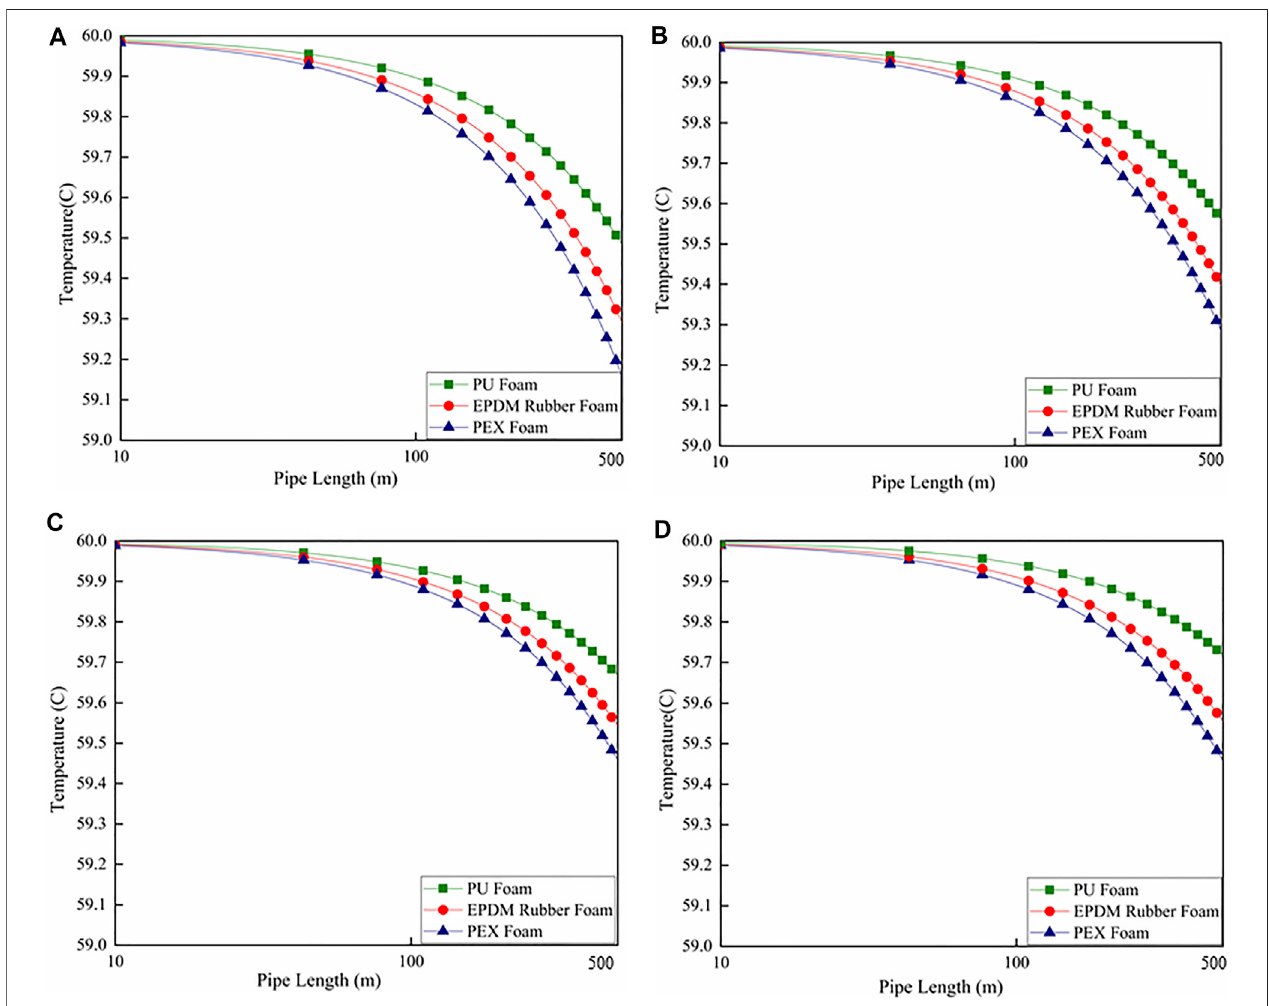
FIGURE 4 | Average Temperature drop along the pipe length during.